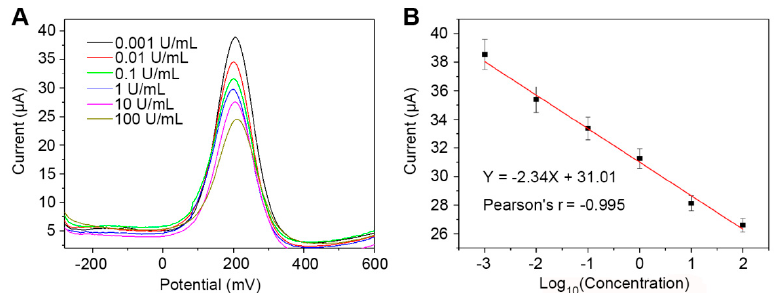
Figure 6. The immunosensor has a wide linear range for detection of CA242 in human serum. ( a ) Differential pulse voltammetry detection of different concentrations of CA242 ranging from 0.001–100 U/mL. ( b ) Calibration curve showing the sensitivity of the immunosensor for the detection of CA242. Error bars represent the mean ± standard deviation ( n = 3).